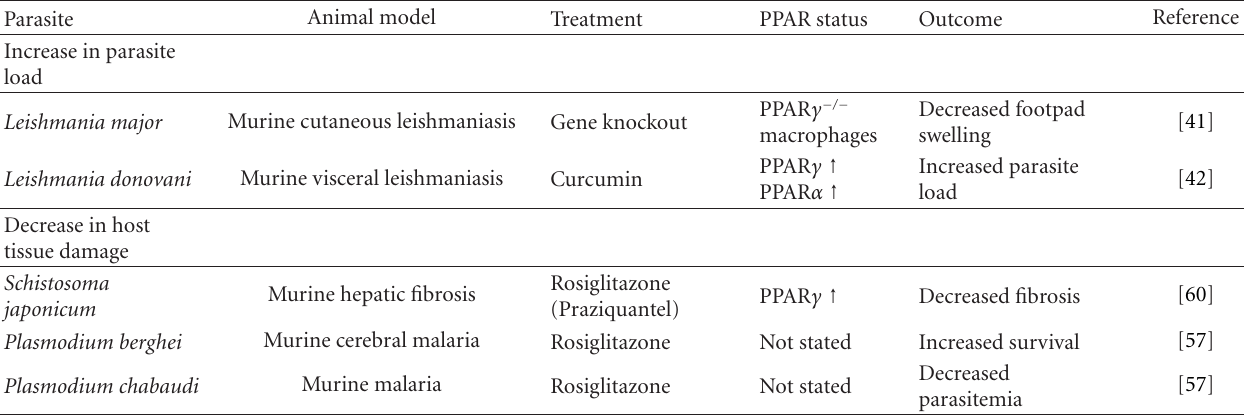
Table 1: E ff ect of PPAR modulation on the outcome of parasitic